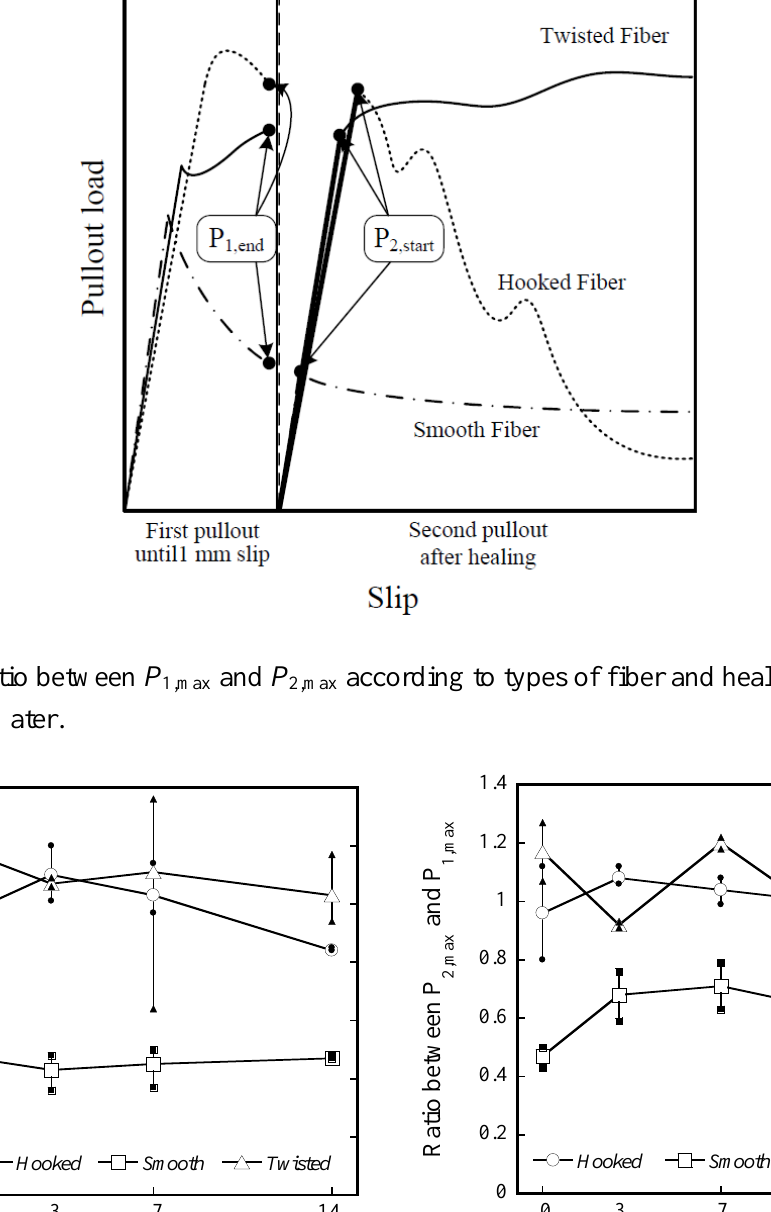
Figure 4. Pullout behavior of high-strength steel fibers after pre-damage up to 1-mm slip.